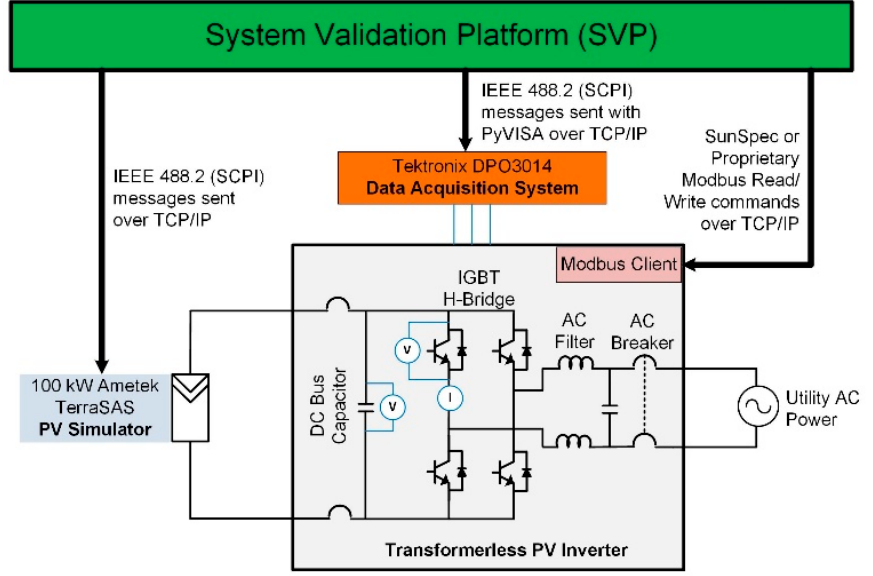
Figure 2. Schematic of the SVP system and component-level reliability measurement of an inverter using an oscilloscope.